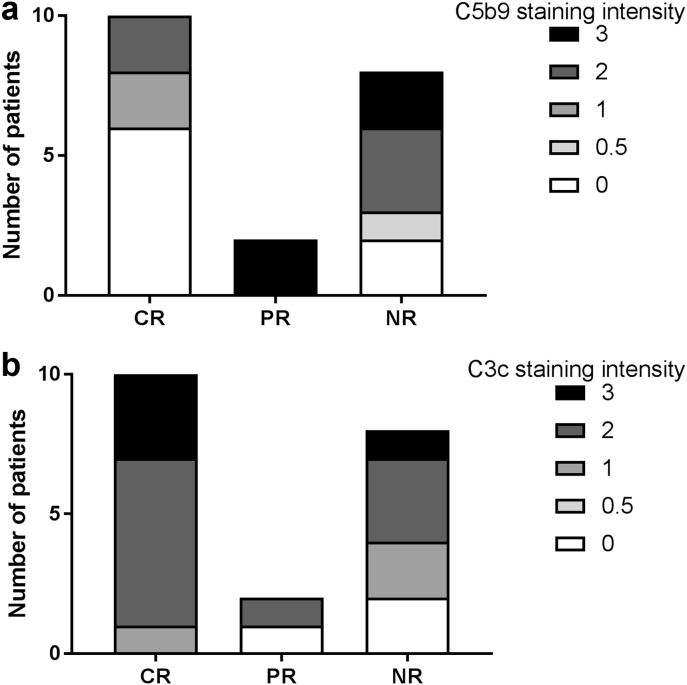
Capillary wall C5b-9 and mesangial C3c staining intensities and treatment response. There was a significant difference in capillary wall C5b-9 staining intensity between treatment responses at 1 year. Patients with more intense C5b-9 staining were more likely to be nonresponders (P = 0.01). There was a significant difference in mesangial C3c staining intensity between treatment responses at 1 year. Patients with more intense C3c staining were more likely to be responders (P = 0.04). CR, complete response; NR, nonresponse; PR, partial response.